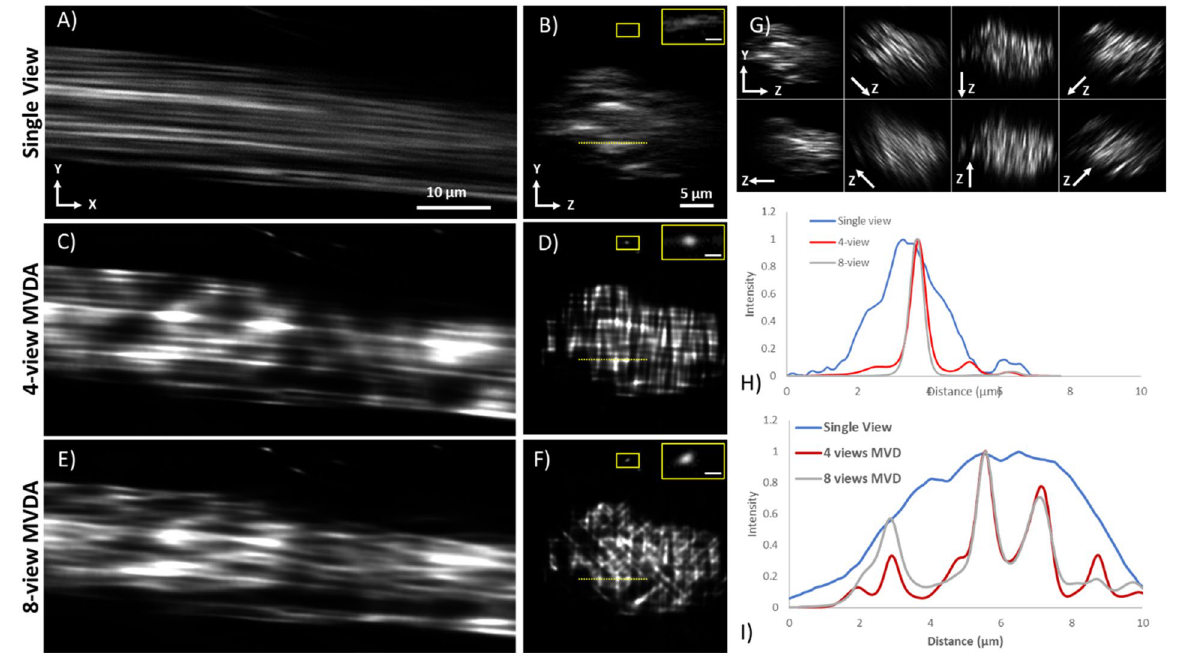
( E ) XY plane ( F ) YZ plane (sagittal section). ( G ) YZ planes (sagittal sections) of all individual registered views. The direction of the Z-axis is indicated in each view. ( H ) Normalized intensity plot profiles of the fibre on the insets of ( B ), ( D ), and ( F ) contrast has been increased for visualization. ( I ) Normalized intensity plot profiles of the dotted lines in ( B ), ( D ), and ( F ). More individual fibres are revealed in the profiles of 4-view MVDA and 8-view MVDA. Scale bar on the inset of ( B ), ( D ), ( F ) 1 μm. (Images were created with Fiji 26